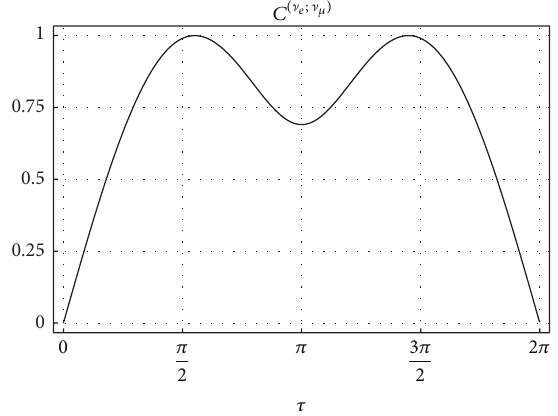
Figure 1: QM instance. The concurrence 𝐶 ( ] 𝑒 ; ] 𝜇 ) as function of the scaled time 𝜏 = (𝜔 2 − 𝜔 1 )𝑡 . The mixing angle 𝜃 is fixed at the experimental value sin 2 𝜃 = 0.314